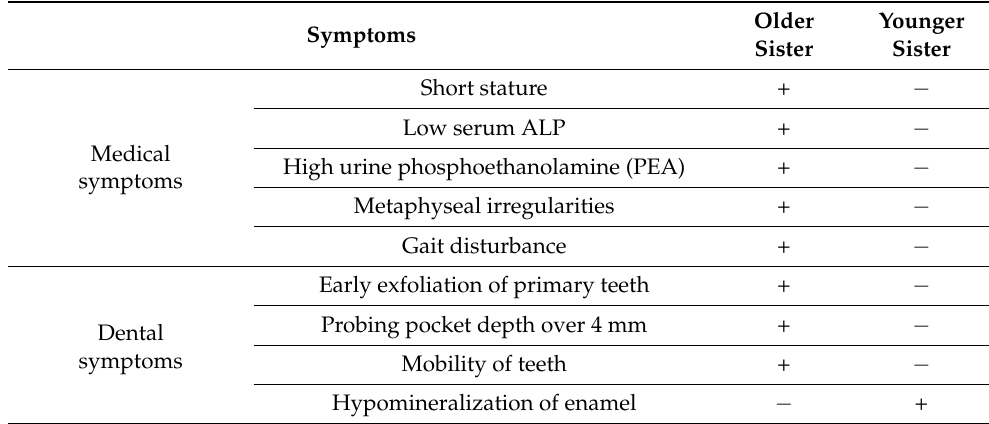
Table 1. Medical and dental symptoms of the two sisters.